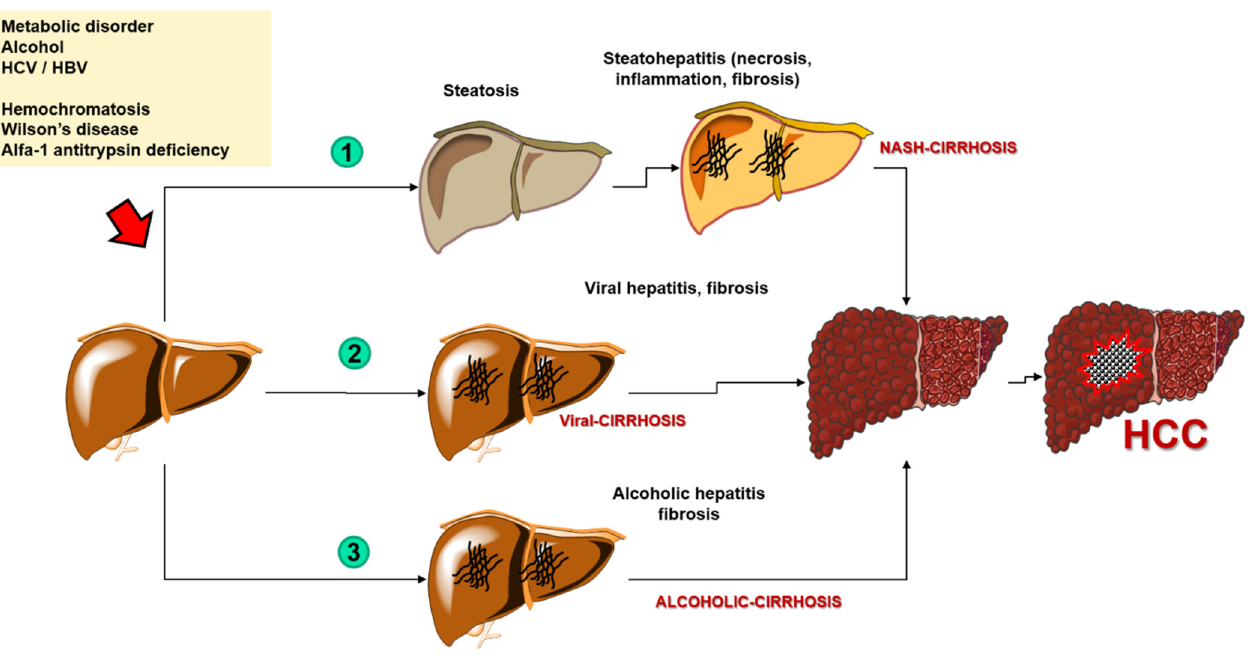
Figure 1. The process of carcinogenesis of the hepatocellular carcinoma. Abbreviations: HCC— hepatocellular carcinoma; NASH—nonalcoholic steatohepatitis; HCV—hepatitis C virus; HBV— hepatitis B virus.